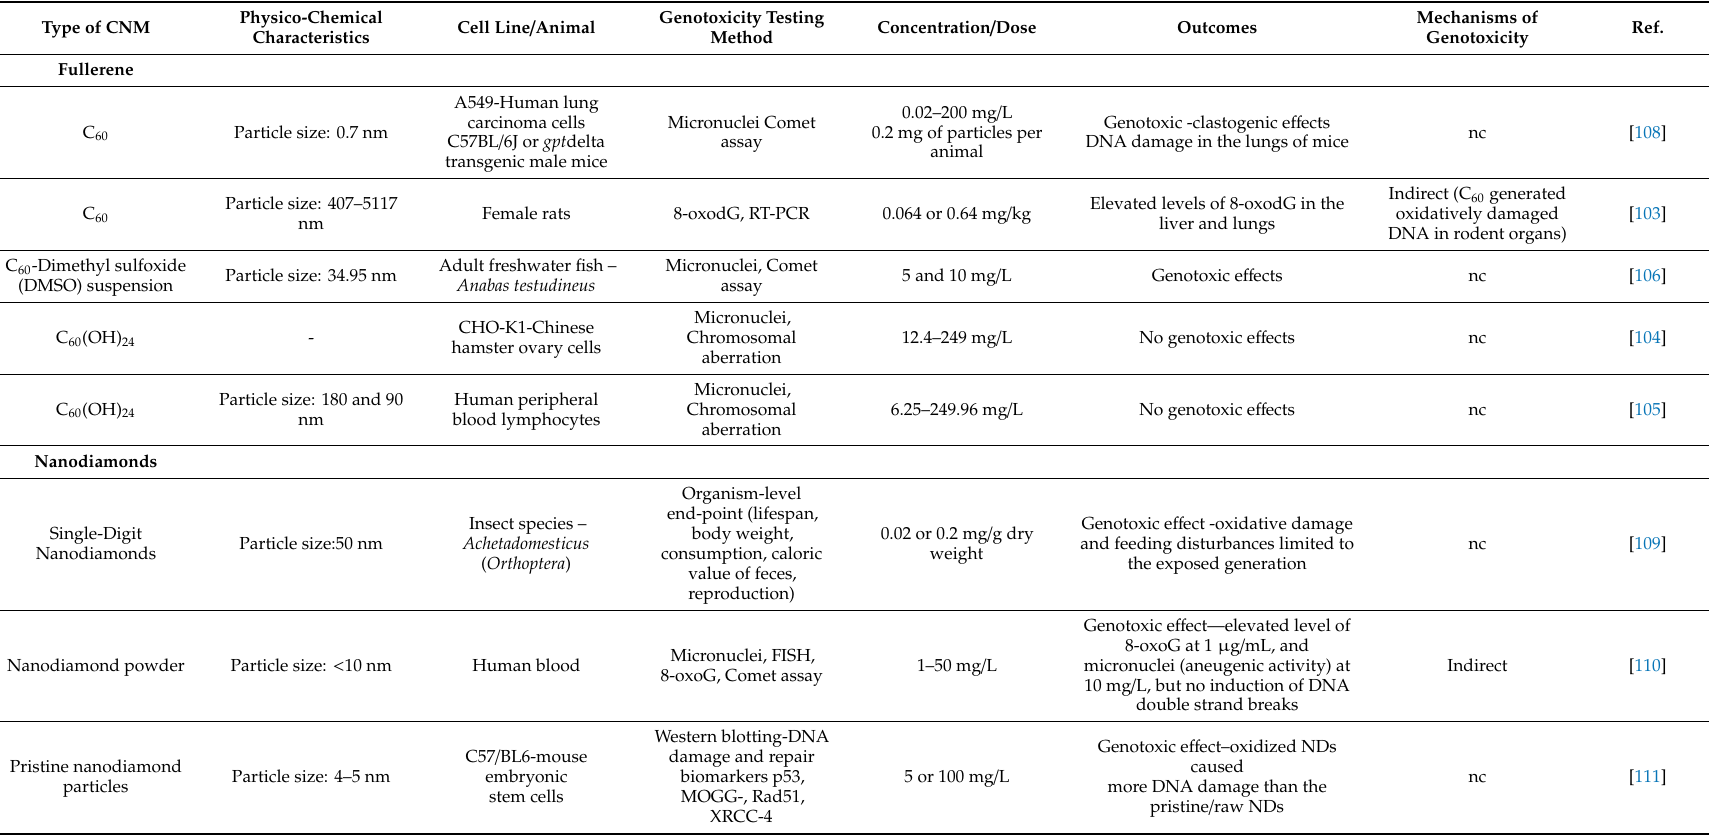
Table 1. The genotoxicity induced by di ff erent types of carbon nanomaterials